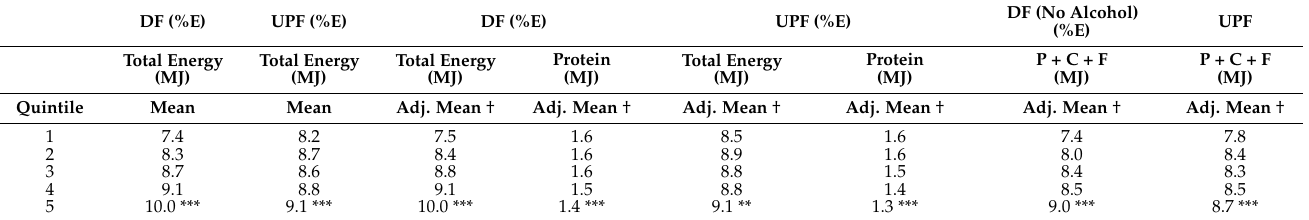
Table 4. Total energy, protein energy and energy excluding alcohol for participants classified by proportion of energy from discretionary food (DF) and ultra-processed foods